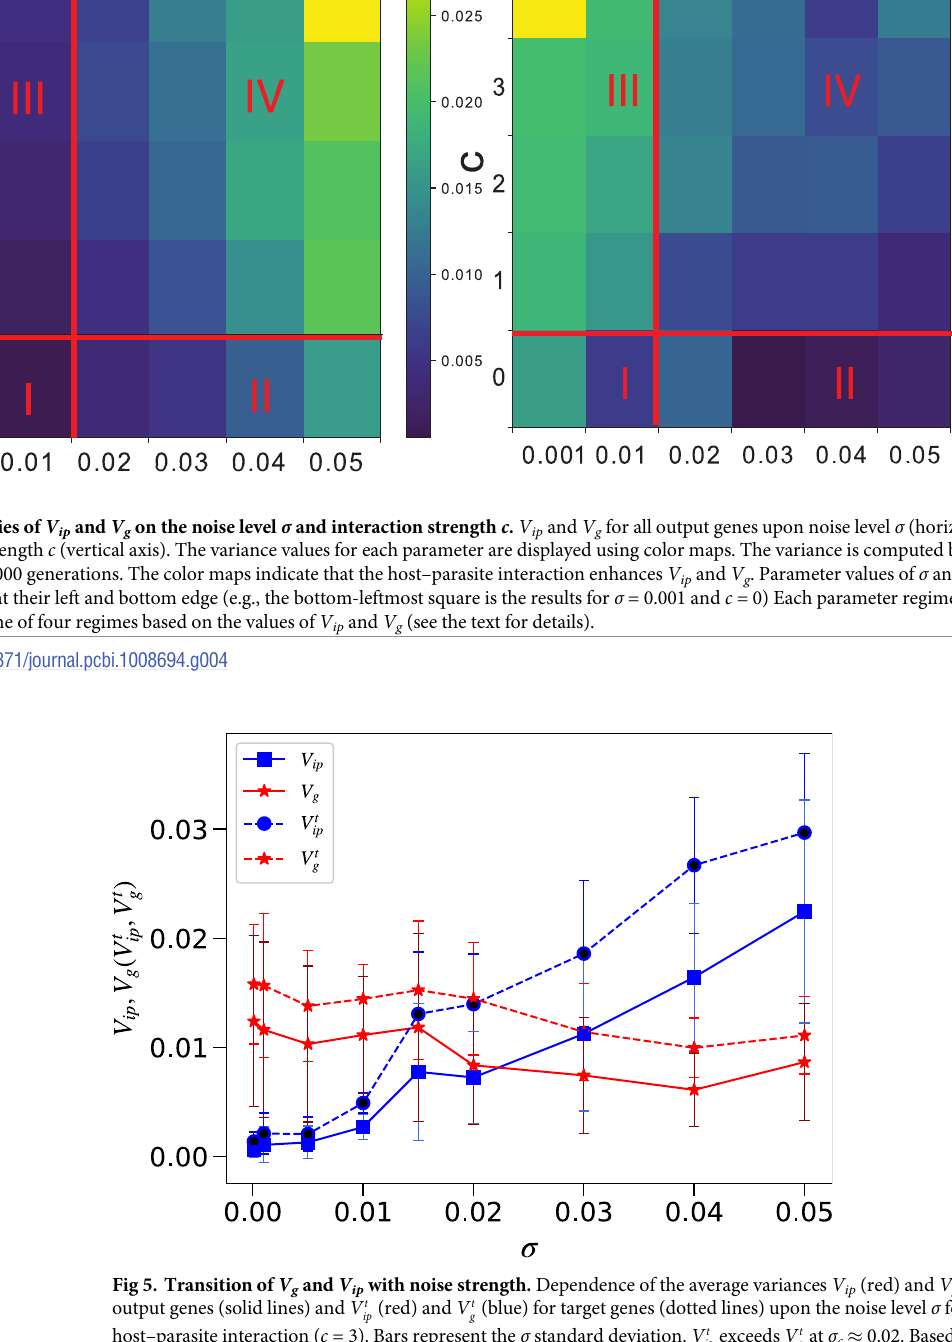
Fig 5. Transition of V g and V ip with noise strength. Dependence of the average variances V ip (red) and V g (blue) for output genes (solid lines) and V t (red) and V t (blue) for target genes (dotted lines) upon the noise level σ for a strong ip g exceeds V t at σ c � 0.02. Based on the data host–parasite interaction ( c = 3). Bars represent the σ standard deviation. V t ip g in Fig 4, the phenotypic diversification occurs for all parameter values here, but the main origin of the phenotypic variances changes from the mutation to the noise at σ � σ . c